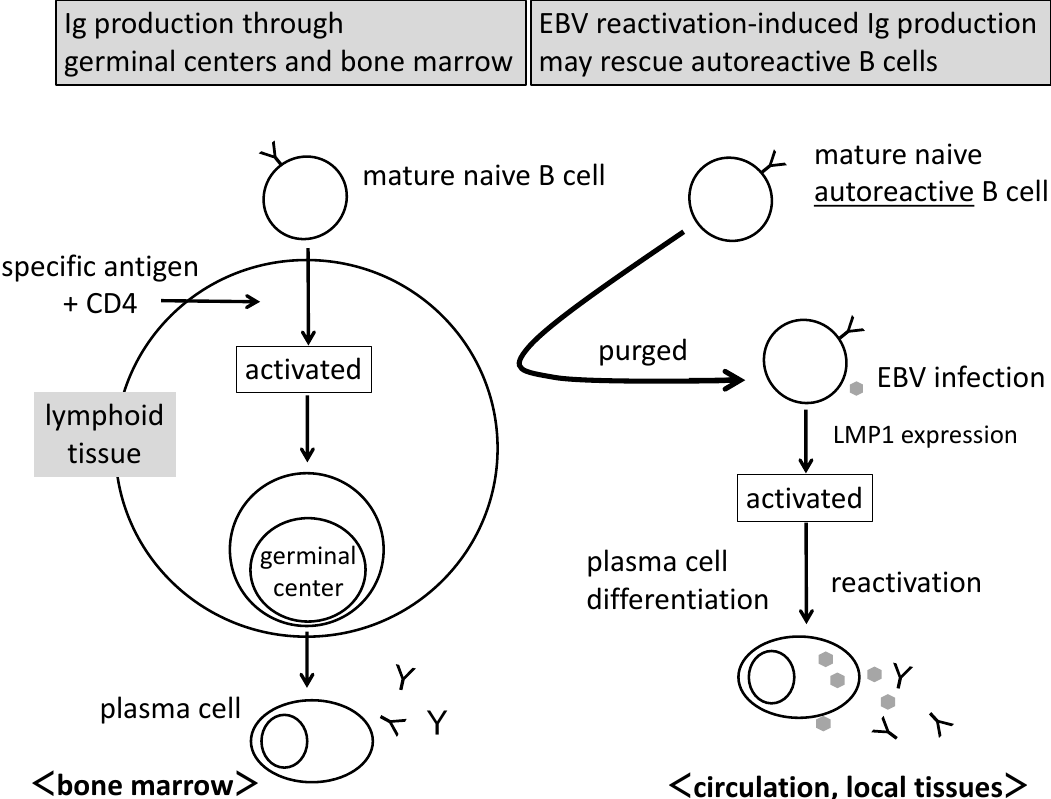
Figure 3. Rescue of autoreactive B cells. Left: Pathway of Ig production through germinal centers and bone marrow. B cells are activated by the presentation of their specific antigens for cognate CD4 T cells and a CD40 signal. Activated and proliferated B cells form germinal centers to a ffi nity-matured class-switched antibodies in bone marrow. Right: Autoreactive B cells that have di ffi culty entering lymphoid tissue may activate and produce antibodies through EBV reactivation-induced Ig production. EBV-LMP1 is known to constitutively mimic the CD40 signal [12]. Therefore, EBV plays a role